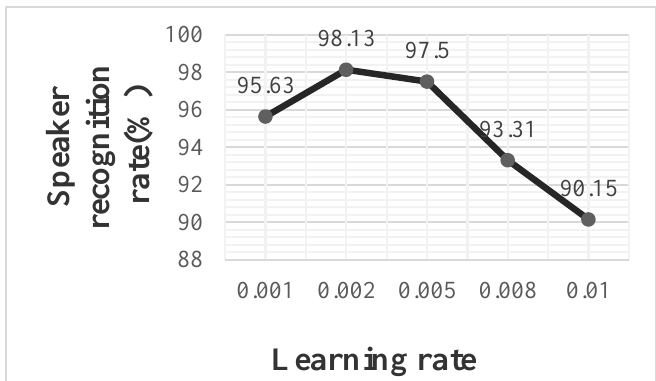
Figure 5. Speaker recognition rate with different batch sizes.